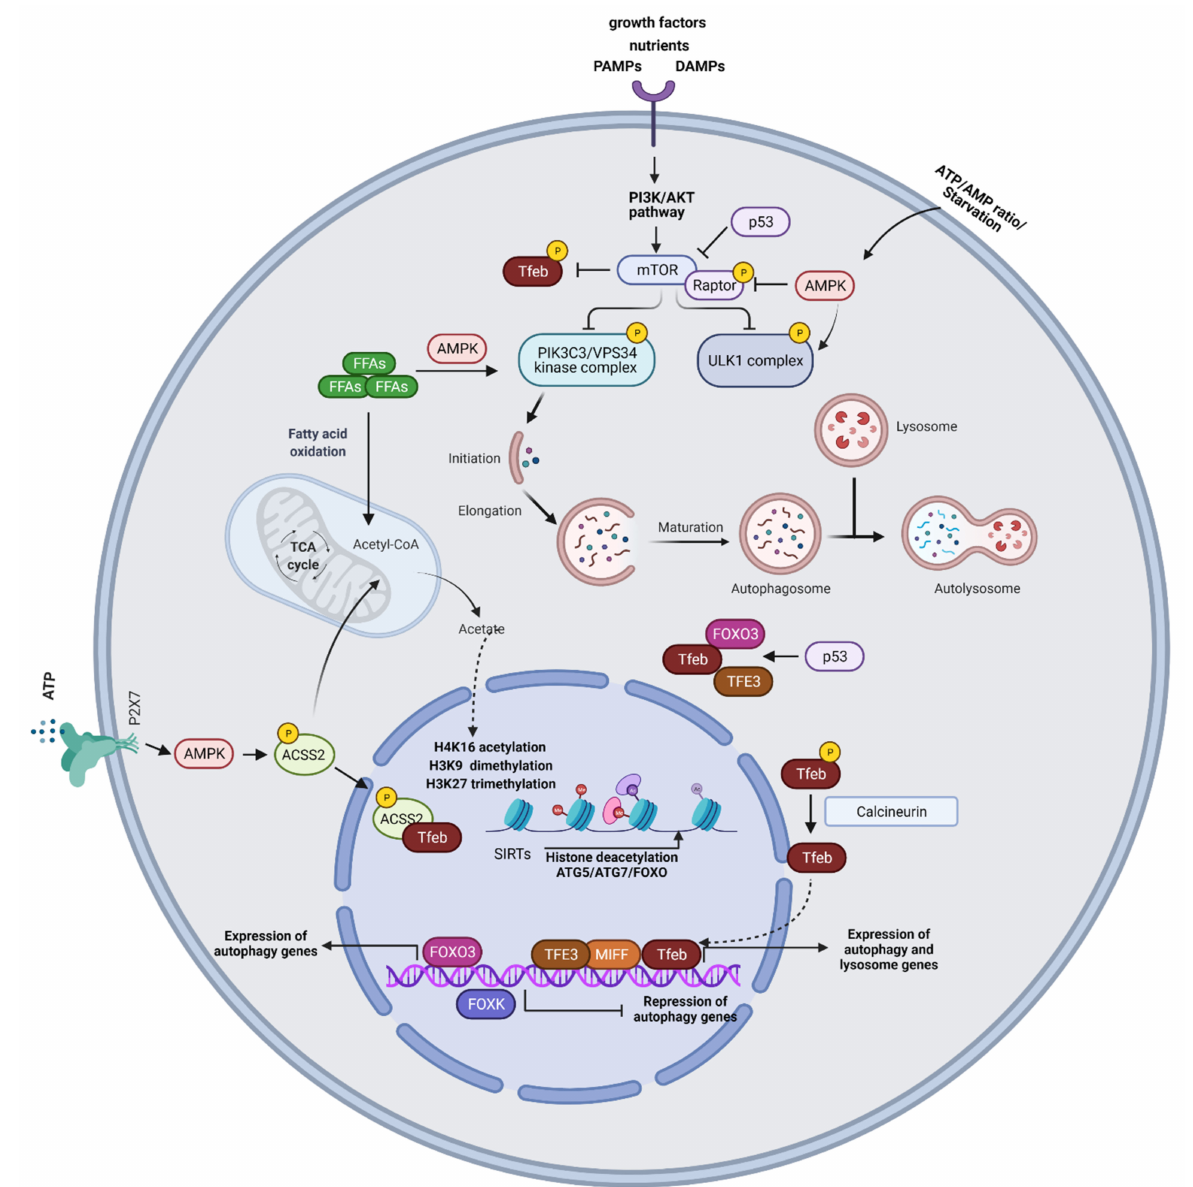
Figure 1. Mechanisms of autophagy regulation. MTORC1 induces inhibitory ULK1 phosphorylation and impedes au- tophagy activation. Under cellular stress, such as starvation conditions, mTORC1 activity is inhibited allowing ULK1 complex activation. MTORC1 also phosphorylates and inactivates regulatory subunits of the PIK3C3/VPS34 kinase complex and phosphorylates TFEB. AMPK senses changes in intracellular ATP/AMP concentrations and under starvation conditions, AMPK phosphorylates ULK1, initiating autophagy. Moreover, AMPK induces inhibitory phosphorylation of Raptor. Free fatty acids (FFAs) activate the PIK3C3/VPS34 kinase complex through AMPK. Beta-oxidation of FFAs generates acetyl CoA which feeds the TCA cycle and acts as a substrate for histone acetylation. SIRTs enhance autophagy by deacetylating FOXO, ATG5 , and ATG7 . Activation of TFEB drives its nuclear translocation wherein it promotes the transcription of autophagy and lysosome genes. Under glucose starvation, AMPK activation promotes TFEB nuclear translocation, through the phosphory- lation of ACSS2. ACSS2 binds to TFEB and initiates transcription of lysosome biosynthesis and autophagy genes. ACSS2 also generates acetyl-CoA that is used for histone H3 acetylation and autophagy gene induction. The purinergic receptor P2X7 induces TFEB nuclear translocation through AMPK activation. FOXO3 represents a key transcriptional regulator of autophagy genes. P53 controls the expression and activity of FOXO3 and promotes TFEB/TFE3 nuclear translocation. Epigenetic modifications, including histone H3K9 dimethylation, H3K27 trimethylation, and H4K16 acetylation play an essential role in the regulation of autophagic responses. SIRT1-induced deacetylation of ATG proteins, such as ATG5, ATG7, and LC3, and the FOXO family of transcription factors are also involved in autophagy